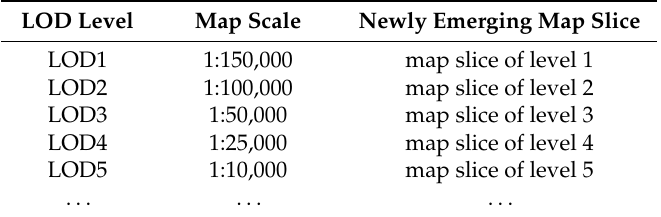
Table 1. The relationship between the key map scales and the newly emerging map slices.